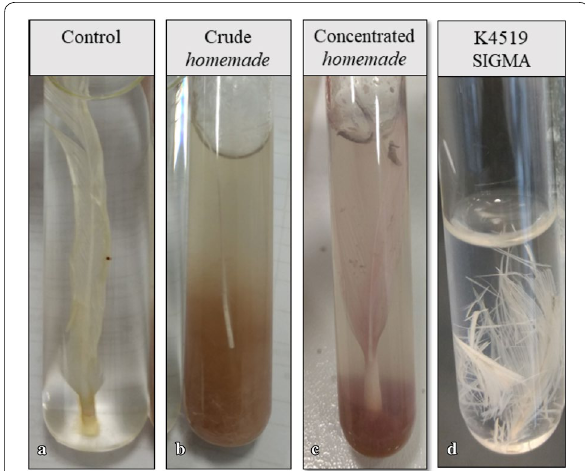
Fig. 2 Total degradation of chicken feathers observed in crude enzymatic extracts and after exposure to reaction systems. a Control; b Crude; c Concentrated; d K4519 SIGMA commercial